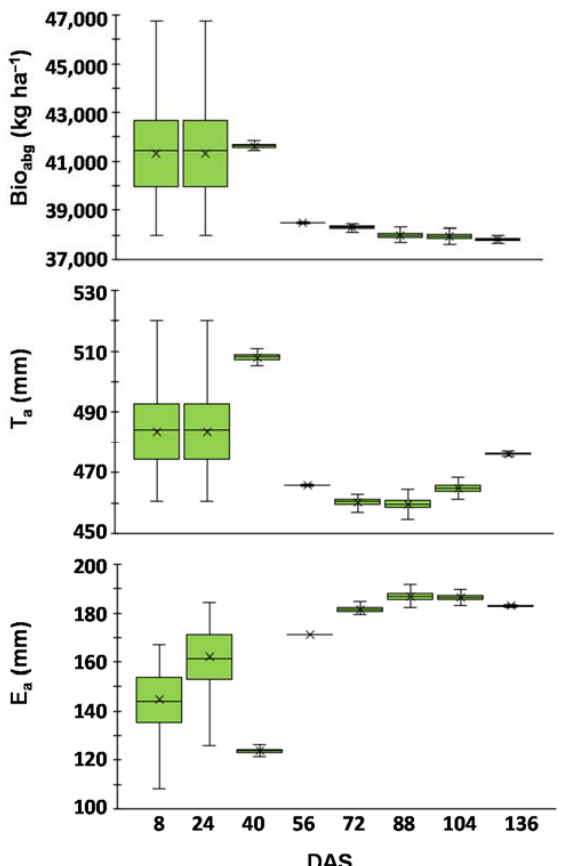
Figure 7. Uncertainty of data assimilation on aboveground dry biomass ( top ), actual transpiration T a ( middle ) and actual soil evaporation E a ( bottom ) final model estimates for the 2015 crop season on different dates (DAS, days after sowing). Box-plots indicate maximum and minimum values, median (–), first and third quartiles and average ( × ) of 10,000 Monte Carlo simulations.